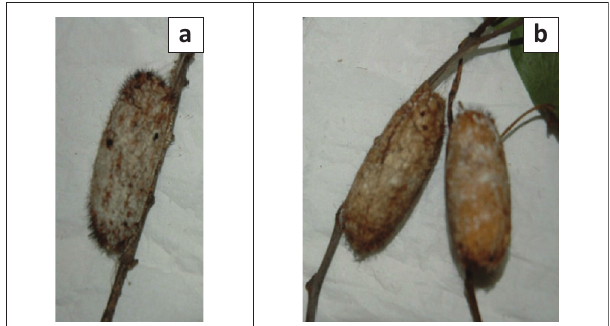
FIGURE 3: Occupied pupal cocoons of the southern African wild silkmoth species ( Gonometa spp . ) attached to twigs of acacia (a) and mopane (b)